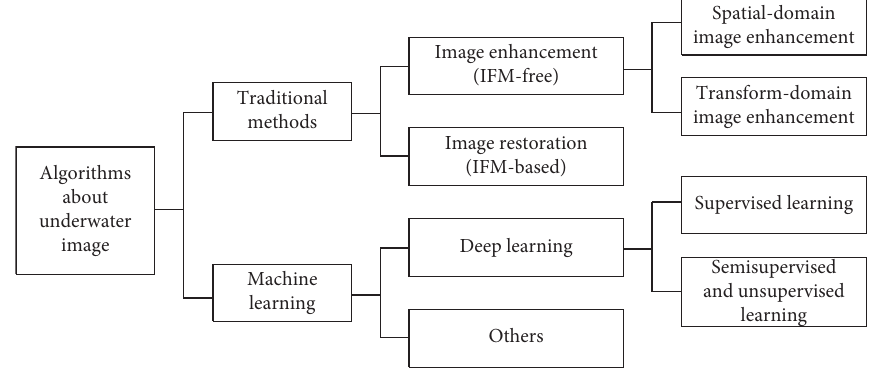
Figure 2: Categories of the quality improvement algorithms about single underwater image. Table 1: The key difference between image enhancement and image